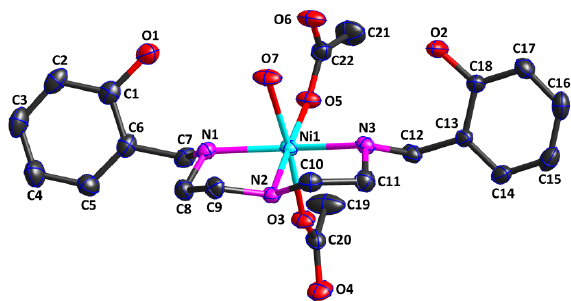
Figure 1. Crystal structure of Complex 1 , showing the 30% probability level of thermal ellipsoids (all H atoms are omitted for clarity).